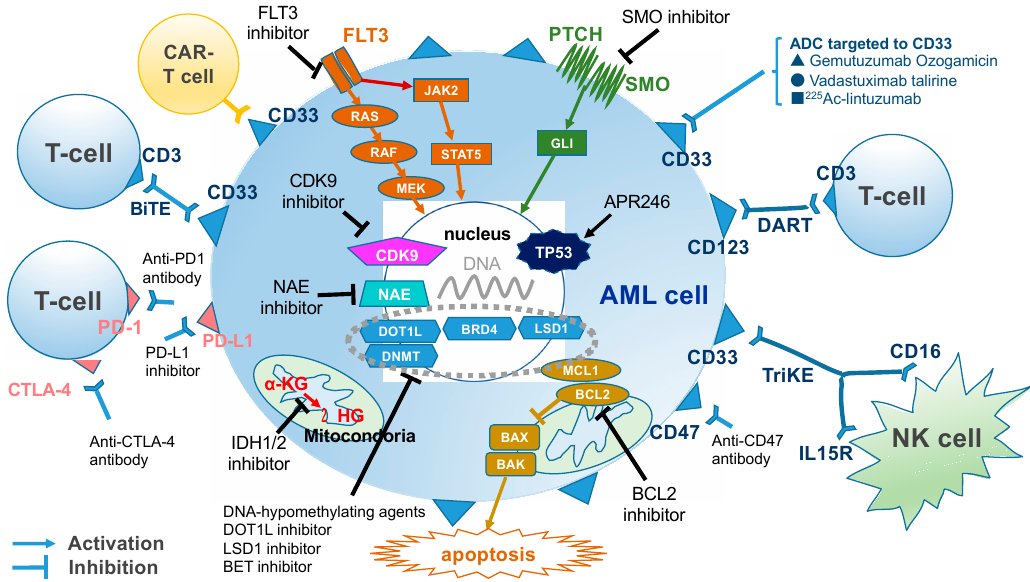
Figure 1. The major targetable pathways and abnormalities in acute myeloid leukemia (AML). Small molecule drugs targeting mutant genes, small molecule drugs targeting signal pathways, drugs targeting epigenetic regulation, antibody therapy, immune checkpoint inhibitors, and adoptive therapy in AML.